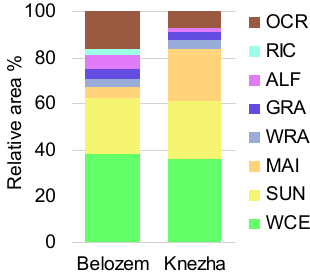
Figure 2. Relative area of the main crops and crop types in the two test sites according to the Integrated Administration and Control System (IACS) 2018 dataset. Crops and crop types are abbreviated as follows: WCE—winter cereals, SUN—sunflower, MAI—maize, WRA—winter rapeseed,